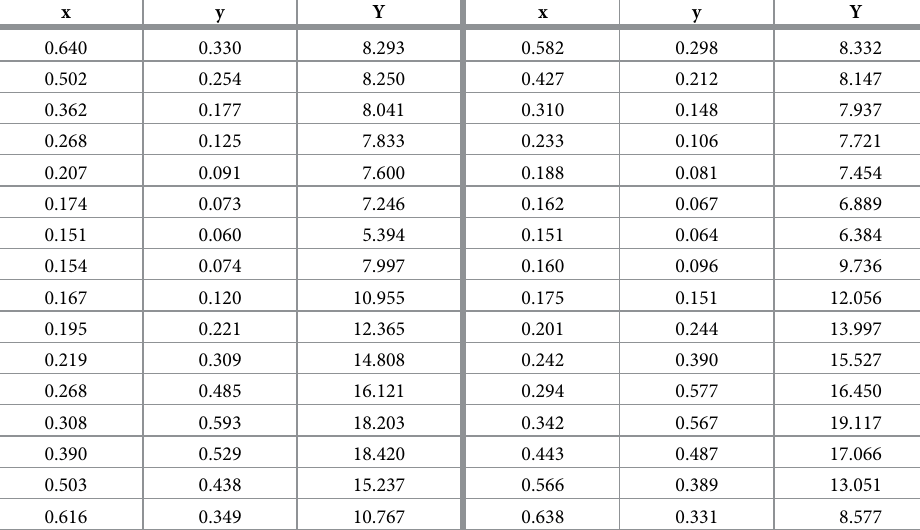
Table 1. CIE xyY coordinates of the tested target